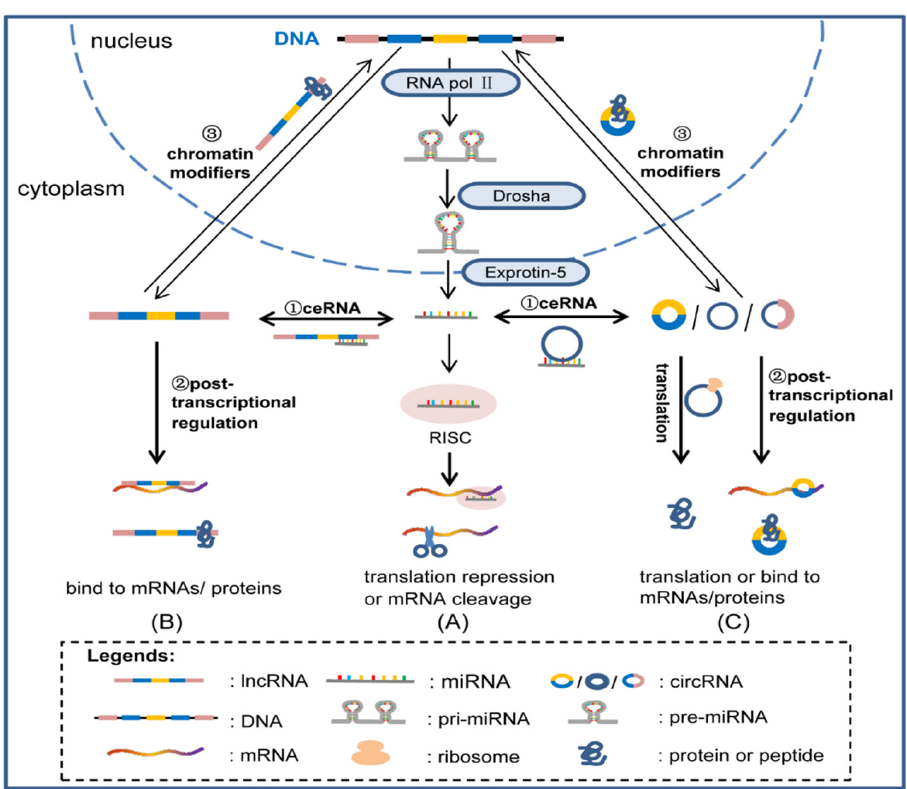
Figure 1. Biogenesis and function of ncRNAs. ncRNA genes are transcribed by RNA Pol II to generate pri-RNAs. Drosha crops pri-RNAs into pre-RNAs, and pre-RNAs are exported from nucleus to cytoplasm by Exportin-5. ( A ) miRNAs direct RISC to downregulate gene expression by mRNA cleavage or translation repression. ( B ) LncRNAs act as signals, and decoy proteins and other RNAs to regulate translation. LncRNAs can bring together multiple proteins to affect histone modifications. ( C ) CircRNAs act as miRNA sponges and interact with RNA binding proteins, and function as protein scaffolds and modifiers of parental gene expression. CircRNAs can also be translated into